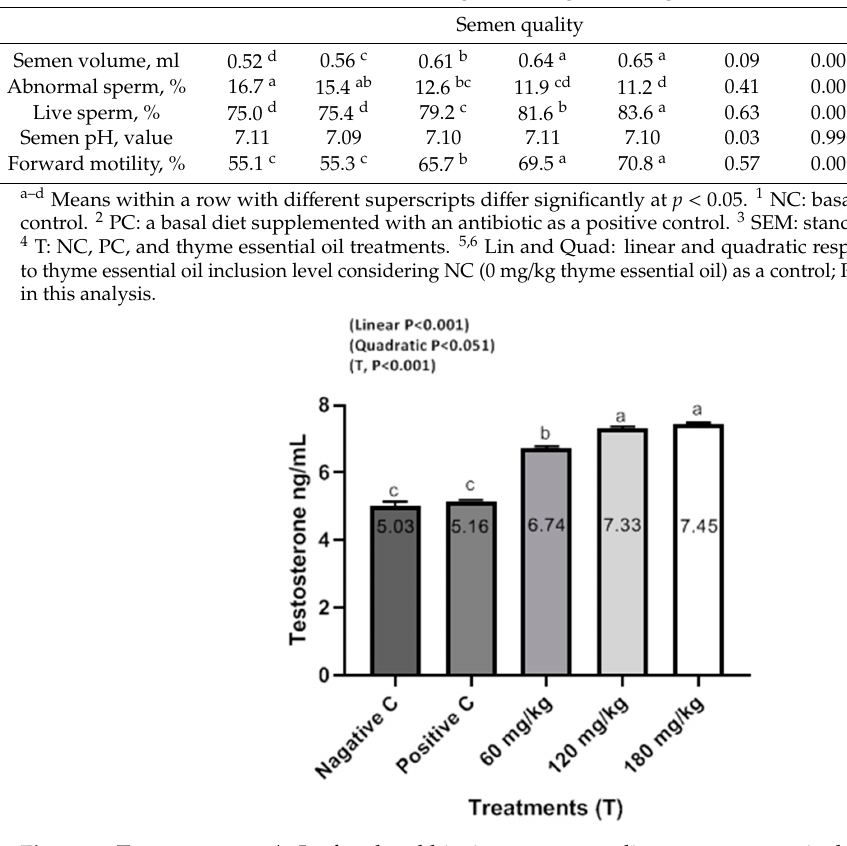
Table 4. E ff ects of thyme essential oil on semen quality of male rabbits at 130 days of age. Items